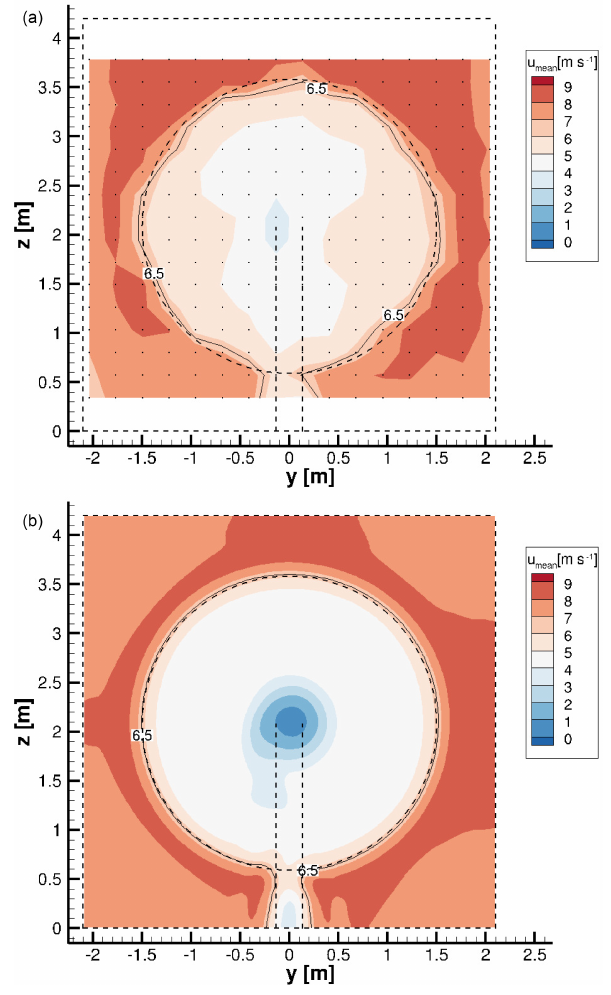
Figure 10. Hot-wire measurements (a) and simulated velocity plane (b) of the x velocity 0 . 5 d downstream of the rotor plane. The dashed lines illustrate the wind tunnel and the turbine. Isolines show the mean inflow velocity of 6 . 5ms − 1 . The dots in (a) show the discrete measuring points.